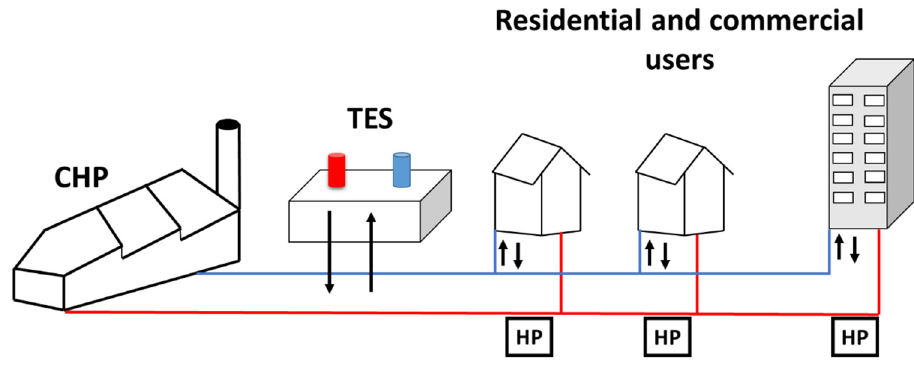
Figure 3. A traditional DH system supply line is red, while the return line is